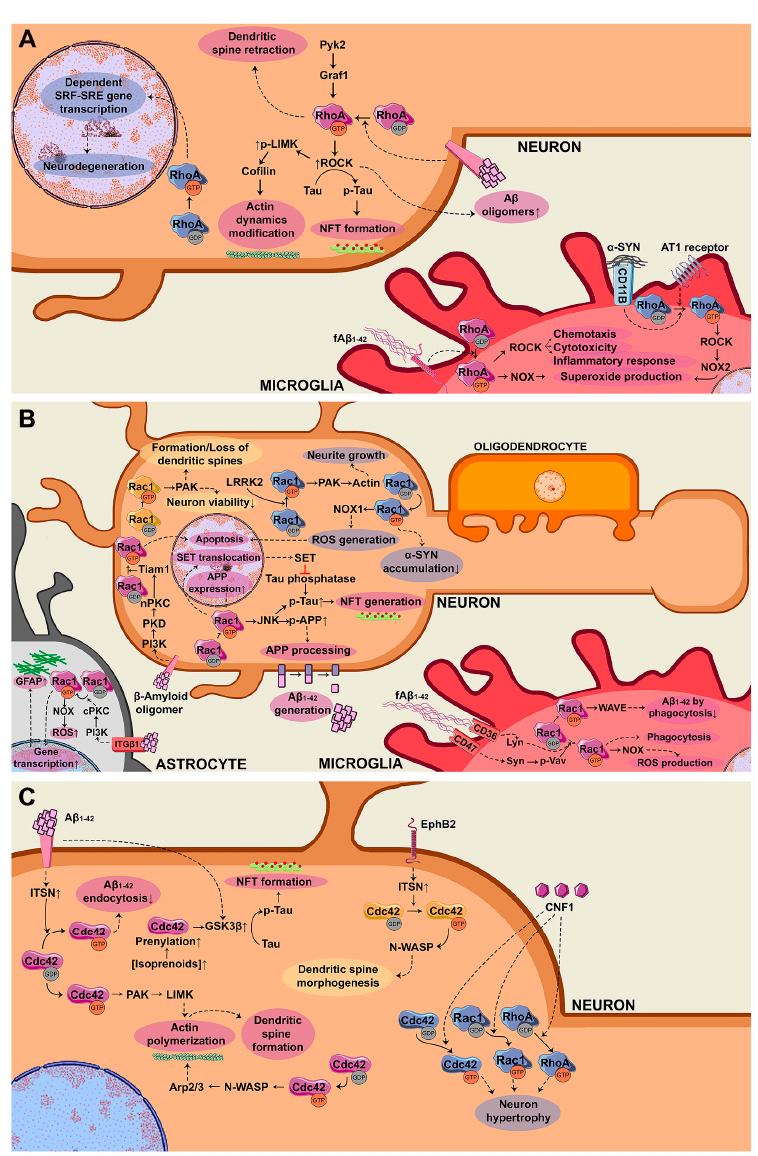
Figure 3. Scheme of the signaling pathways controlled by small GTPases of the Rho family, which are deregulated in general (yellow), in AD (purple), and PD (blue) in neurodegenerative diseases. ( A ) RhoA GTPase signaling pathways in neurons and microglia. RhoA / ROCK controls SRF–SRE gene transcription in neurons. In microglia, RhoA is activated via α -Synuclein ( α -syn) / CD11B / RhoA and AT1 / RhoA. ( B ) Signaling axis controlled by Rac1 GTPase in neurons, astrocytes, and microglia. In neurons, Tiam1 / Rac1, Rac1 / NOX1, and Rac1 / JNK are inducing neurodegeneration, whereas the Rac1 / PAK axis can drive neurodegeneration according to the input. Rac1 also decreases α -syn accumulation. In astrocytes, ITG β 1 / PI3K / cPKC / Rac1 is leading to neurodegeneration, promoting astrogliosis by an increase of its gene expression targets and reactive oxygen species (ROS) generation. In microglia, the Vav / Rac1 axis is a ff ecting neuronal viability by both, generating ROS and phagocytosis activation. On the other hand, Rac1 / WAVE is decreasing A β 1–42 levels by activating phagocytosis. ( C ) Signaling cascade controlled by Cdc42 GTPase in neurons. The axes intersectin (ITSN) / Cdc42 and Cdc42 / GSK-3 β , together with RhoA and Rac1, are driving to neurodegenerative